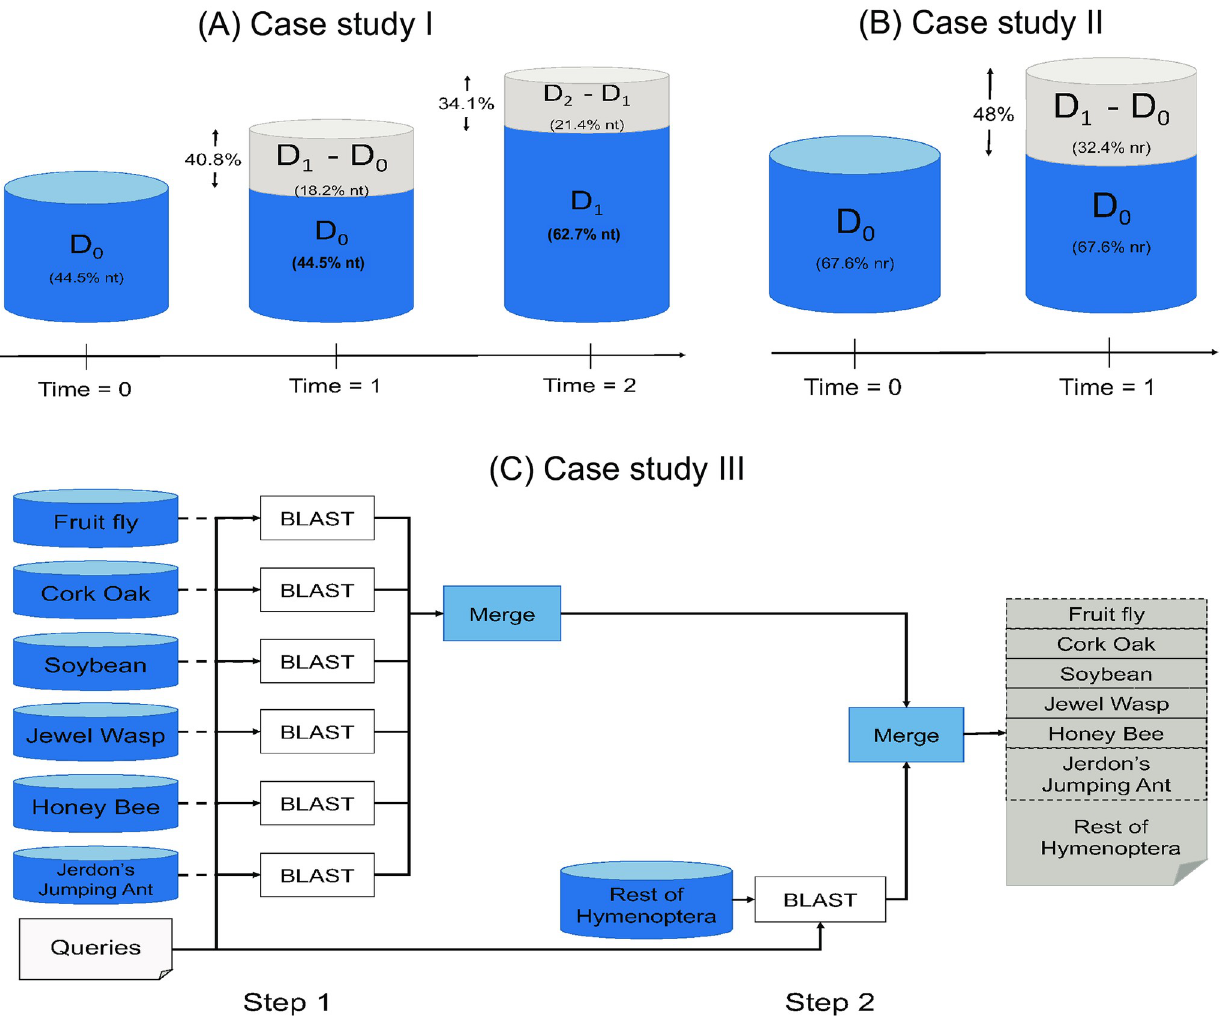
Fig 3. Experimental design of three case studies. (A) Case study I: Incremental addition of sequences in the nt database over three time periods. (B) Case study II: Incremental addition of sequences in the nr database over two time periods. (C) Case study III: Incremental search of taxon-specific databases.